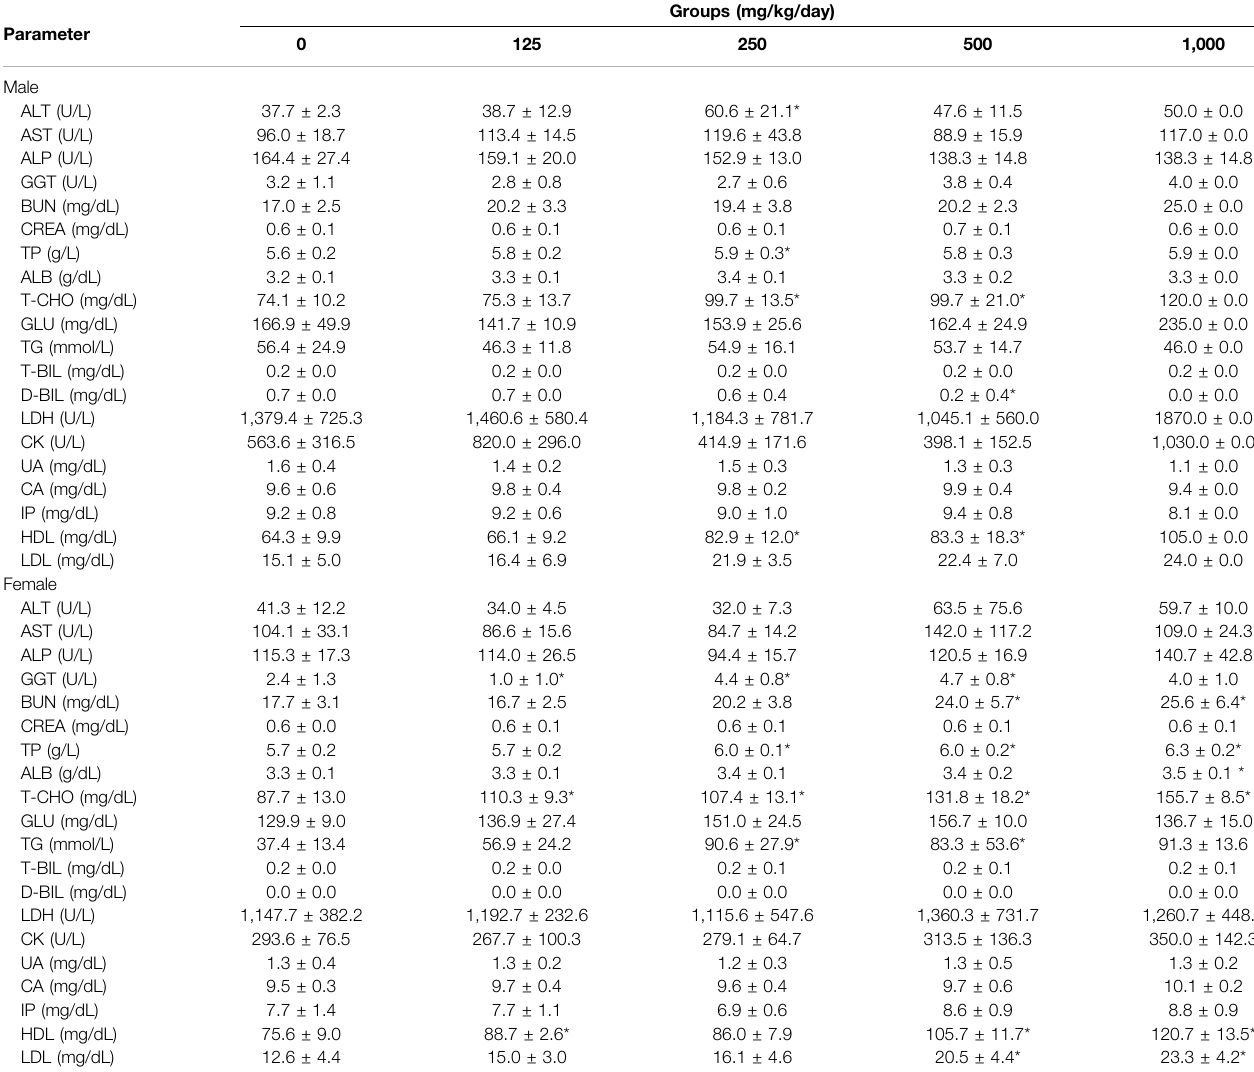
TABLE 5 | Clinical biochemistry parameter of BCP in male and female rats.